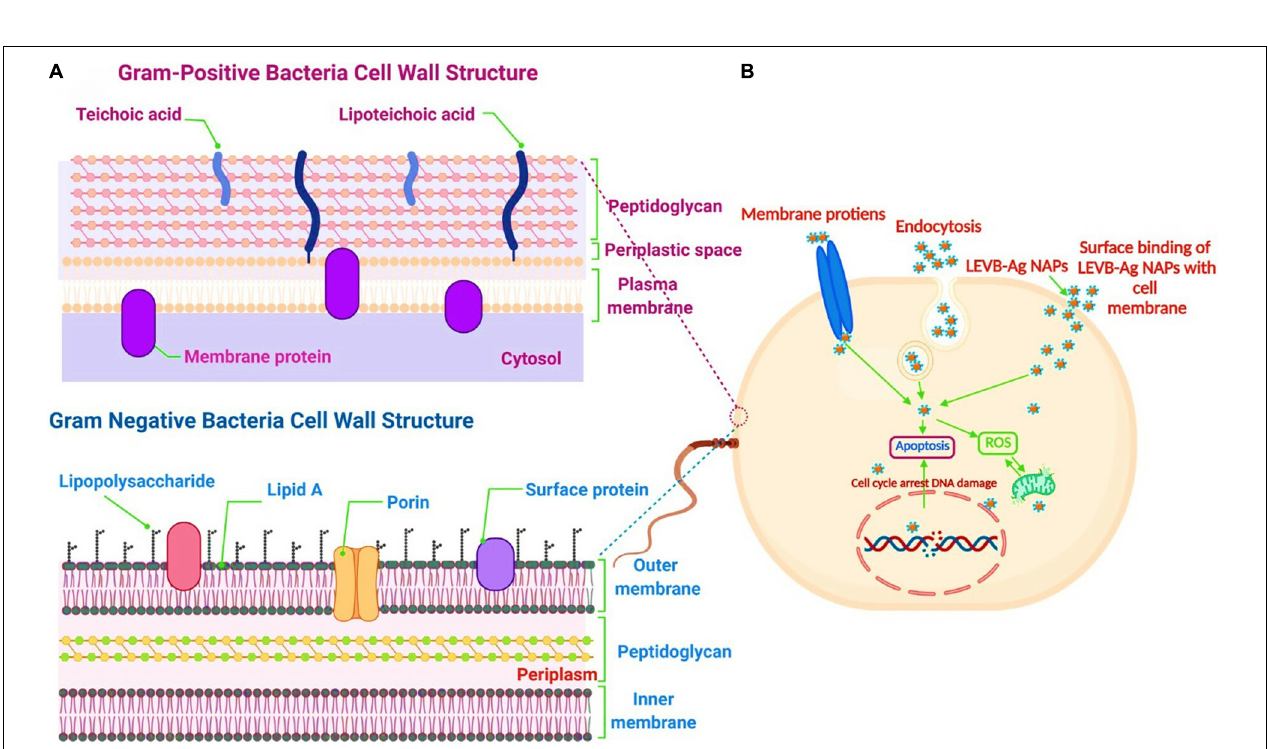
FIGURE 6 | (A) The cell wall comparison between Gram-negative and Gram-positive bacteria. (B) Proposed antibacterial mechanism of LEVB-Ag NAPs against bacterial strains. Created with BioRender.com.